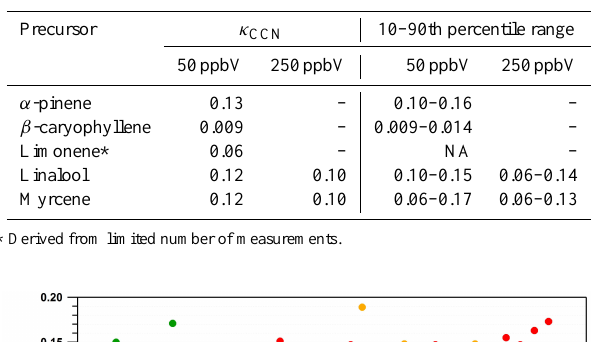
50 ppbV β -caryophyllene κ HTDMA values are slightly higher than κ CCN